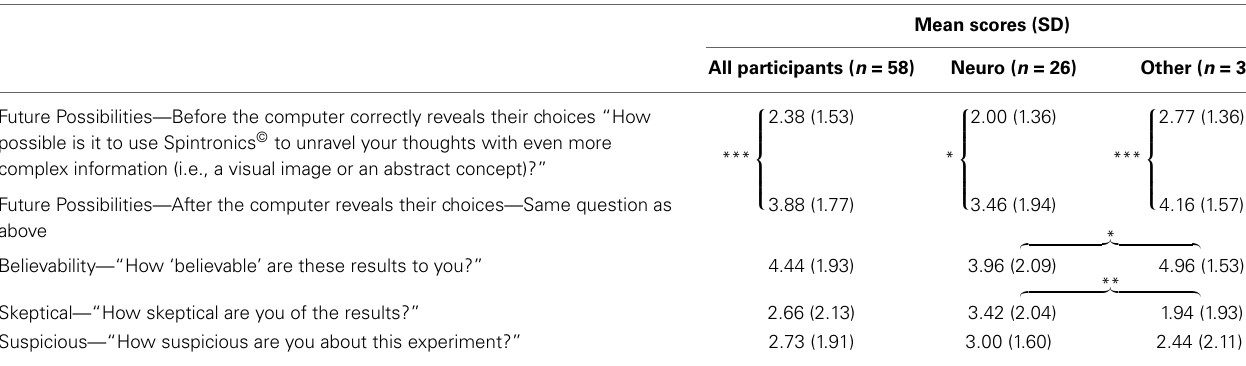
Table 1 | Subjective ratings of participant beliefs concerning the neuro mind-reading paradigm (on a 7-point Likert scale ranging from 0 “not at all” to 6